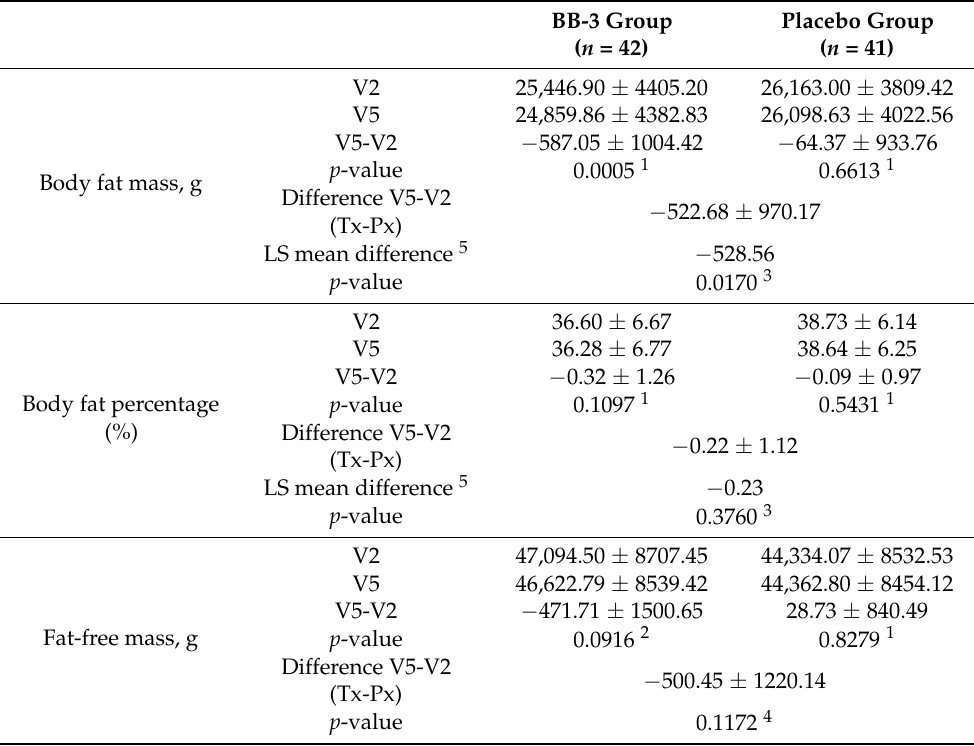
Table 3. DEXA results at 12 weeks from baseline according to the groups (PPS).